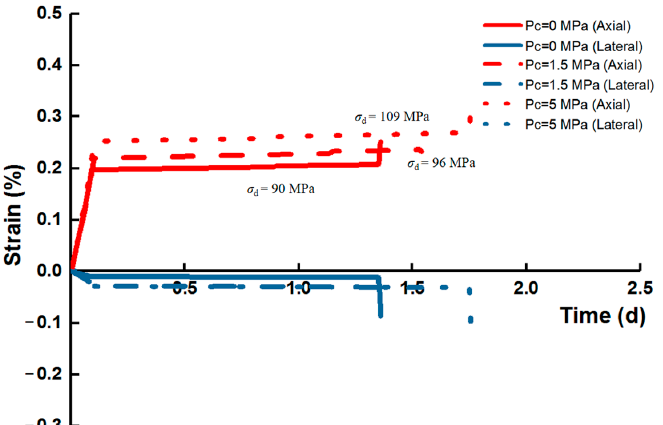
Figure 8. Behavior of creep strain at the last stress level for the constant homogeneity index ( m = 2).